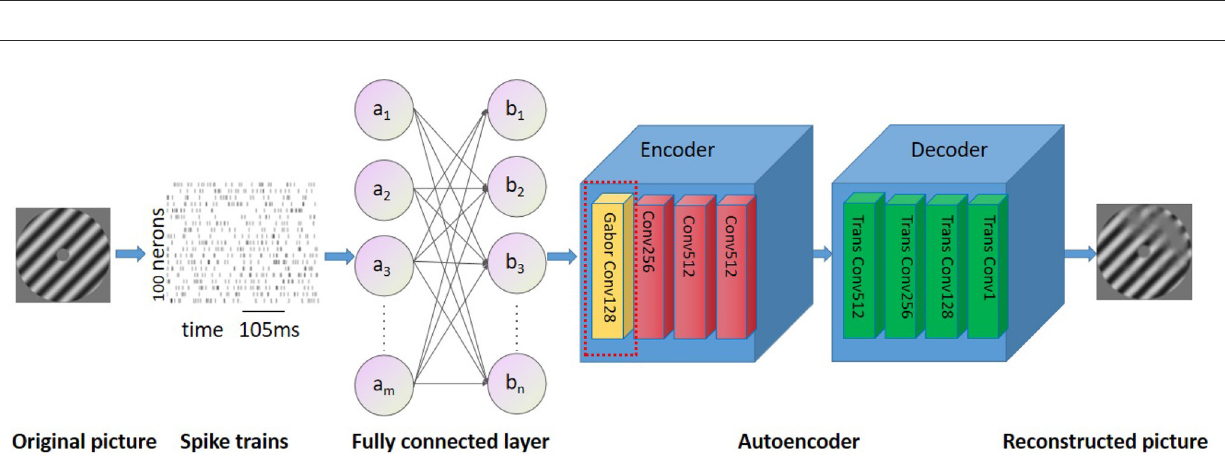
FIGURE4 Overview of the neural network. The proposed network consists of two fully connected layers followed by a Gabor autoencoder.